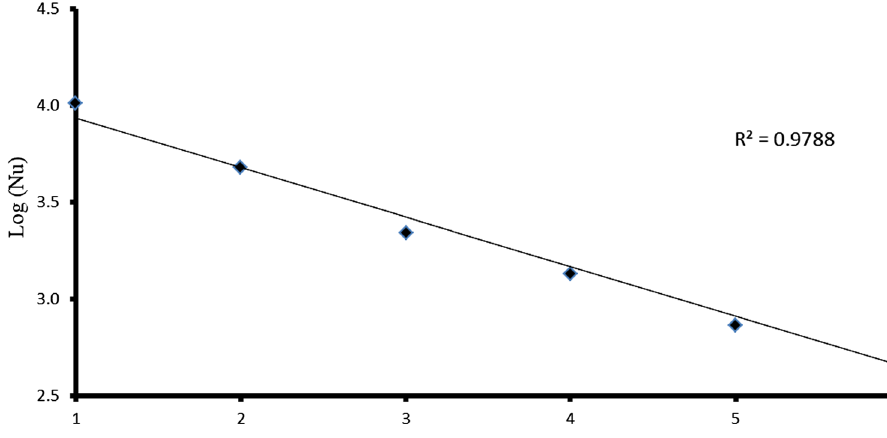
Fig. 4 Logarithm regression of stream number against stream